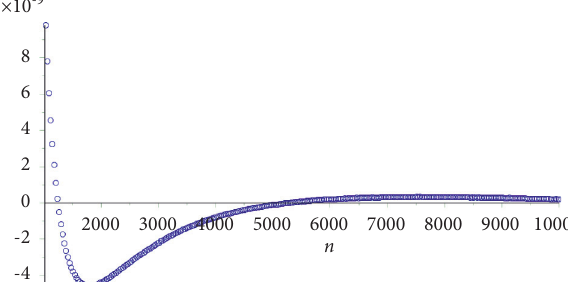
Figure 22: The relative error of I Table 10: The relative error of I